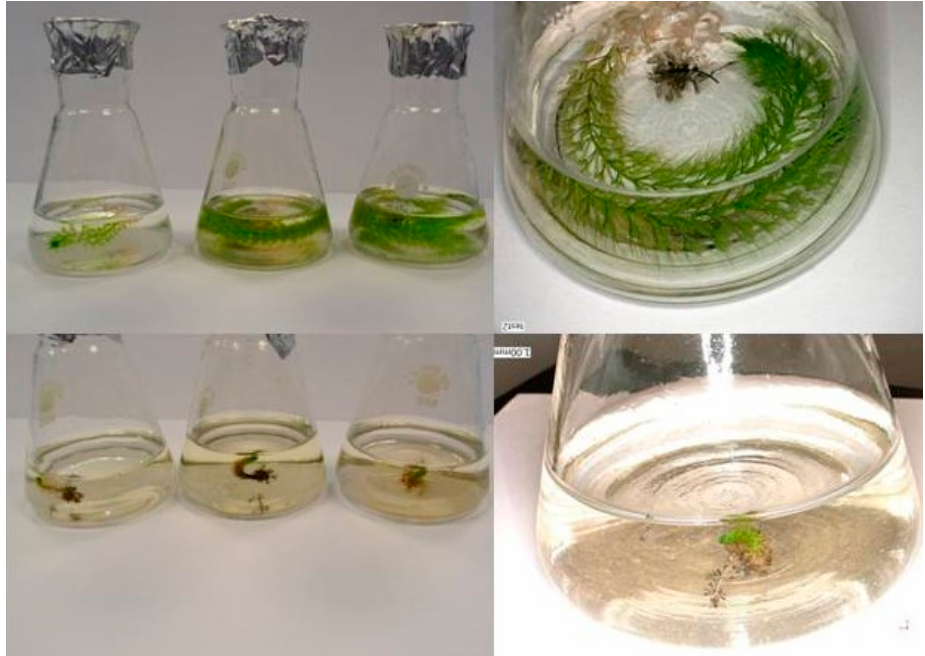
Figure 1. Morphological features of the regenerating explants of Aldrovanda vesiculosa , depending on the addition of silver nanoparticles (AgNPs) to the 1/5 MS culture media.